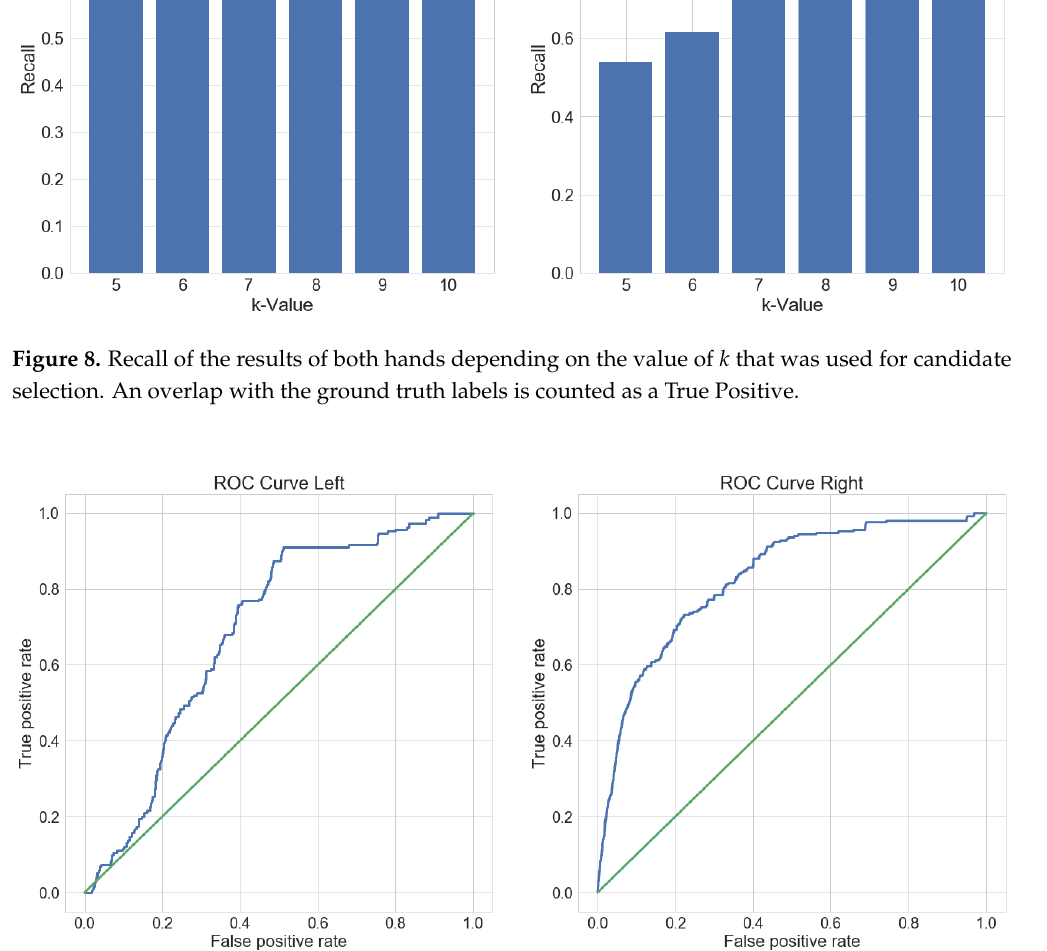
Figure 9. ROC curve for both hands. Without the candidate selection, this plot shows the overall performance of the Dynamic Time Warping algorithm. Again it can be seen that the performance for the left hand data is not as consistent as the performance of the right hand